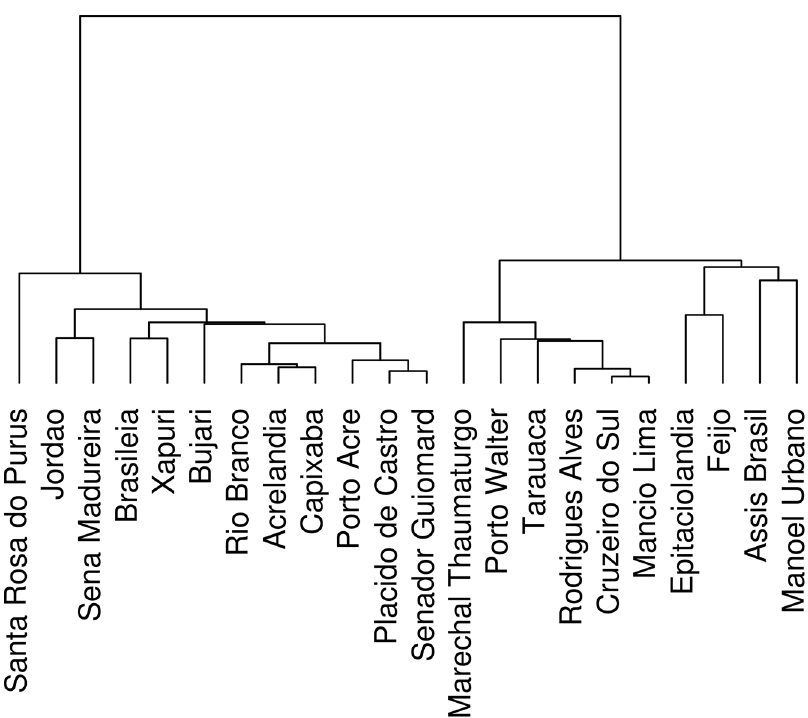
Fig 3. Hierarchical clustering of the 22 municipalities of Acre according to the similarity of the time series of malaria incidence (2003 – 2013).